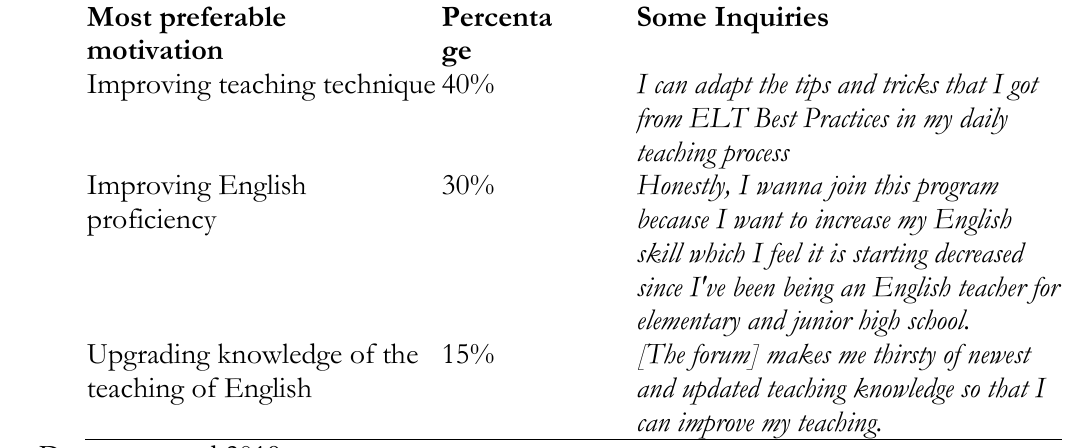
TABLE 1 | Reflection on English Teacher’s Motivation on Joining Academic